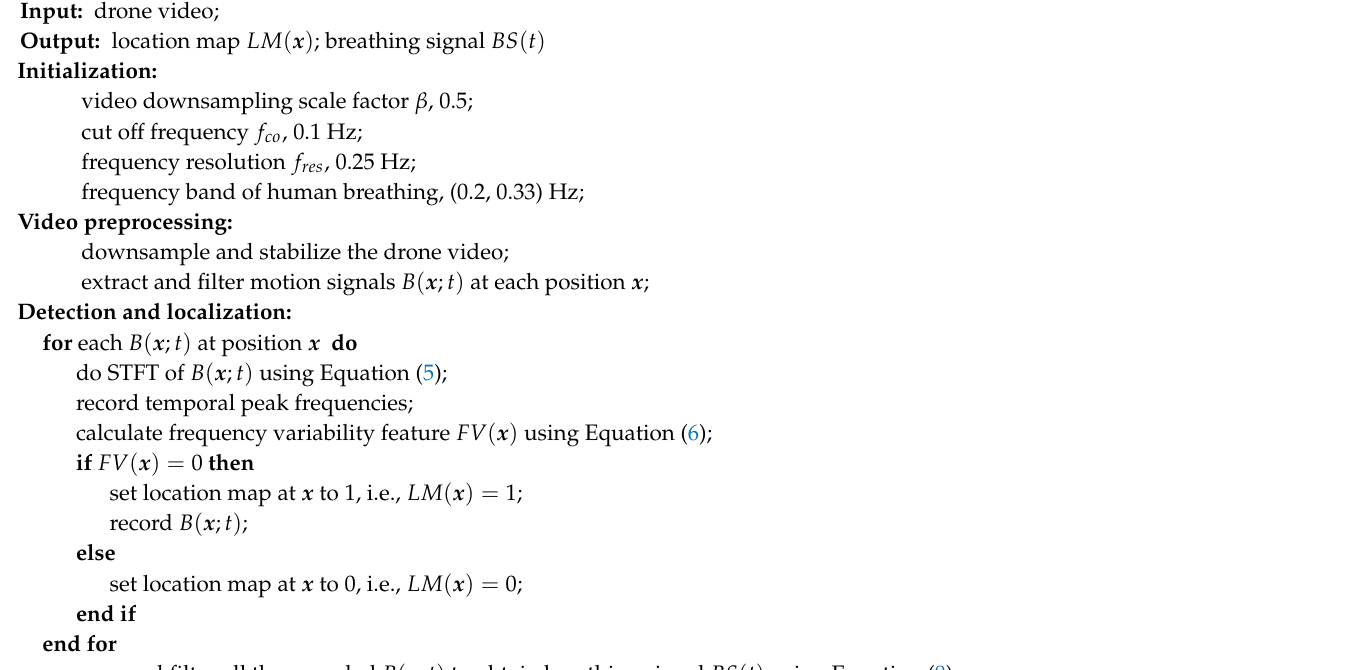
Algorithm 1 Frequency Variability Feature for Life Signs Detection & Localization in Natural